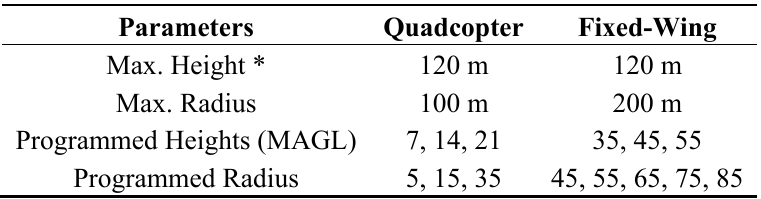
Table 3. Programmed flight parameters and UAV